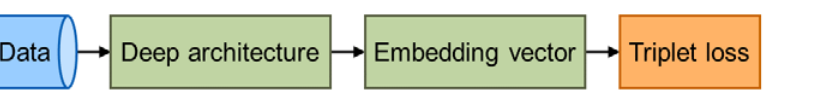
Figure 4. Stage 1 triplet loss and vector length loss learning model.